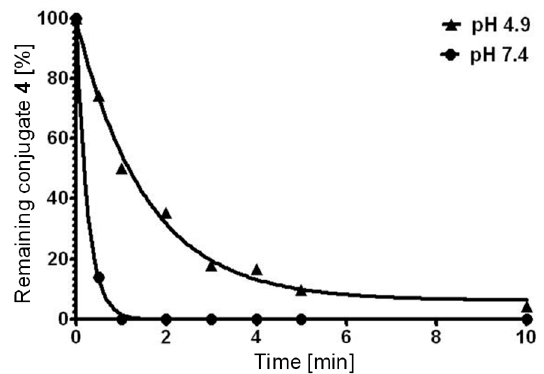
Figure 3. Kinetics of glutathione (GSH)-mediated reduction of epothilone-peptide conjugate 4 (173 µ M 4 , 10 mM GSH, pH 4.9 (endosome-like conditions), triangles, or pH 7.4 (cytoplasm-like conditions), circles). Conjugate 4 was added to the respective GSH solutions as a solution in phosphate buffer pH 7.4 at room temperature, to reach a total concentration of 173 µ M. Samples were quenched at different time points with 10% metaphosphoric acid and analyzed by RP-HPLC. The peak areas for 4 in the RP-HPLC chromatograms were normalized against the peak area of a 200 µ M solution of 4 in the corresponding GSH-free buffers.